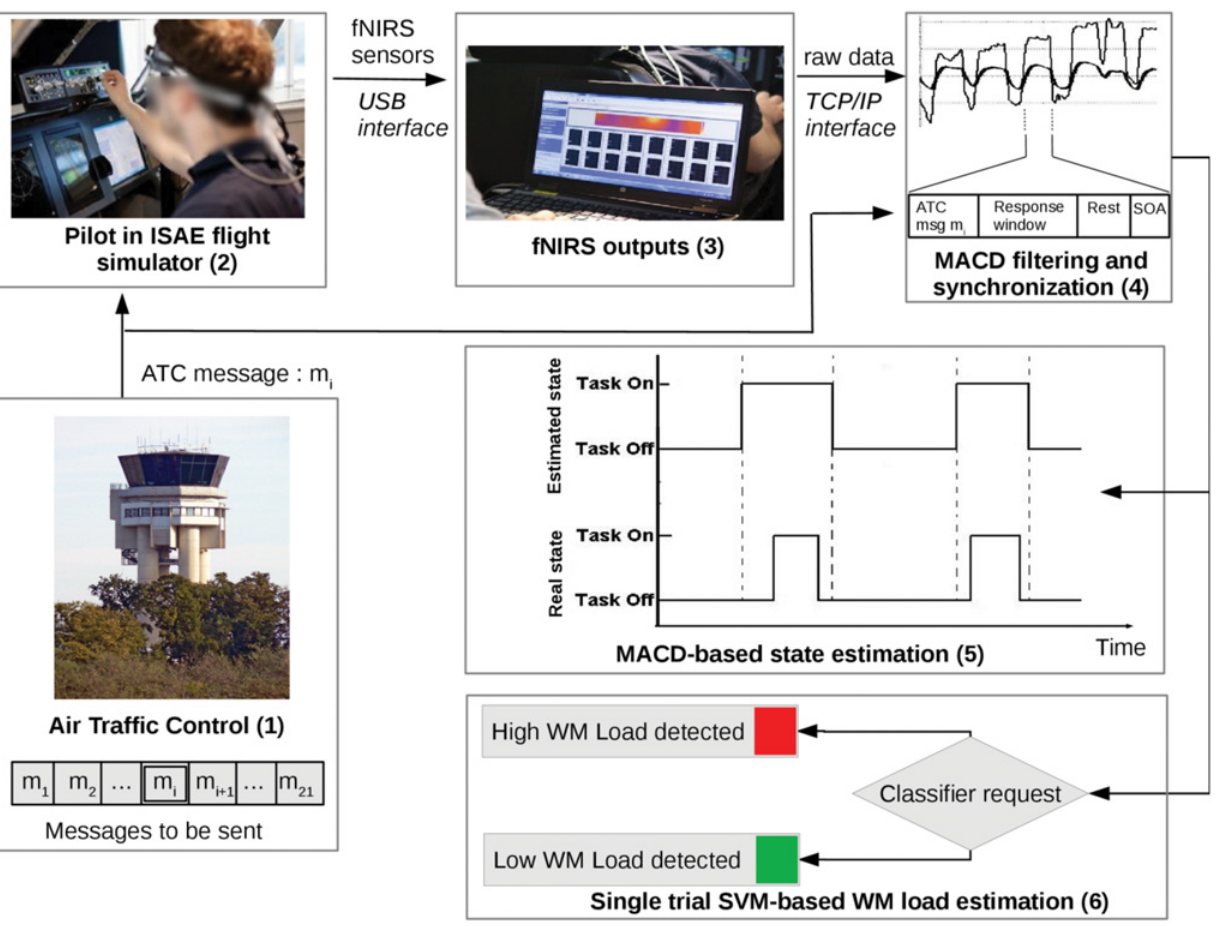
Fig 4. Illustration of the fNIRS based inference system. Pre-recorded ATC messages were sent to the pilot (1). The pilot ’ s prefrontal activity was measured with a fNIRS device (2). Output measures (3) were MACD-filtered and synchronized with the temporal design of the trial (4). During the entire session, the MACD-based state estimator detected whether the pilot ’ s state was not-on-task or on-task (5). When all of the required data were available for the trial, a request was sent to the pilot ’ s classifier to assess the WM load of the trial